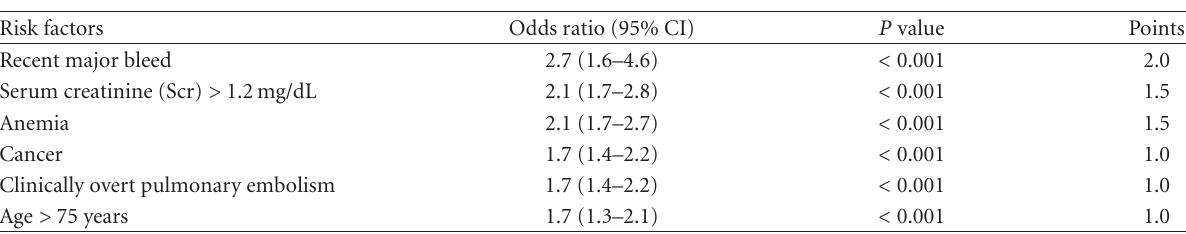
Table 3: Multivariate analysis for major bleeding and bleeding risk index classification [60,